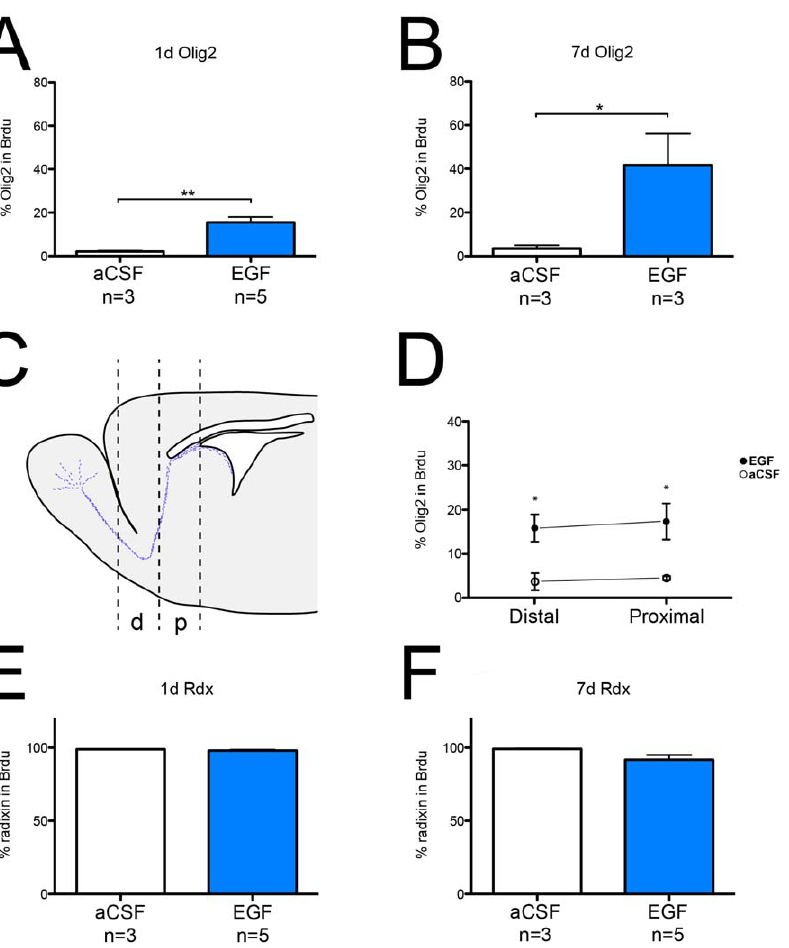
Figure 10. Proliferative response of Olig2 + cells in the rostral migratory stream to EGF infusion. ( A, B ) Quantification of BrdU/Olig2 co- labeled cells reveals an increase in the fraction of Olig2 + cells among the newly generated cells after 1 day (A) and 7 days (B) of EGF infusion. ( C ) Schematic illustration of the proximal (p) and distal (d) rostral migratory stream (RMS) coordinates used for analysis. ( D ) Quantification of the proximal and distal part of the RMS reveals a rapid response of Olig2-positive cells, at both locations, to EGF after 1 day of infusion. ( E, F ) Percentage of radixin (Rdx) expressing cells in newly generated cells (BrdU + ) is close to 100% after 1 day ( E ) and 7 days ( F ) of aCSF and EGF infusion. Data are presented as percent of BrdU + cells 6 SEM. Statistical significance was assumed at * p , 0.05 and ** p , 0.01 using Student’s t -test (A, B) or Mann-Whitney U-test (E, F). ( D ) n(control): proximal=4, distal=3; n(EGF): proximal=5, distal=4.